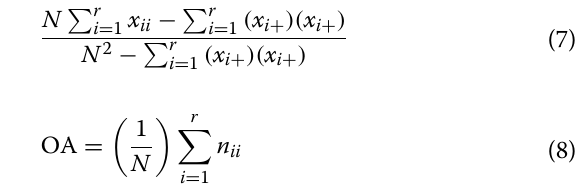
where r was the number of rows in the matrix, x i were the marginal totals of row r and column i , X was the number of observations in row i and column i , N was the total number of observations, and n ii was the number of correctly classifed pixels (Fig. 2).